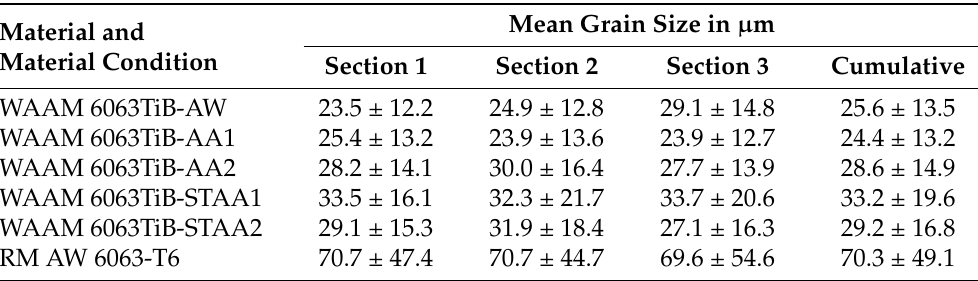
Table 4. The mean grain size of WAAM specimens for different material conditions compared to RM AW 6063-T6.